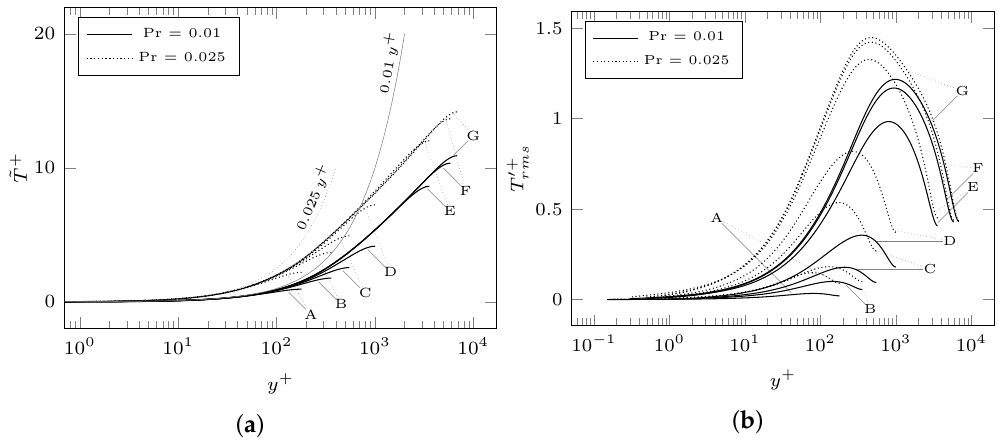
Figure 3. Cylindrical pipe tests (KLW model). Non-dimensional profiles of the mean temperature ˜ T + ( a ) and the root-mean-squared temperature fluctuations T (cid:48) + rms ( b ) as a function of the non-dimensional distance from the wall y + with Pr = 0.025 and 0.01. The cases A, B, C, D, E, F and G are defined in Table